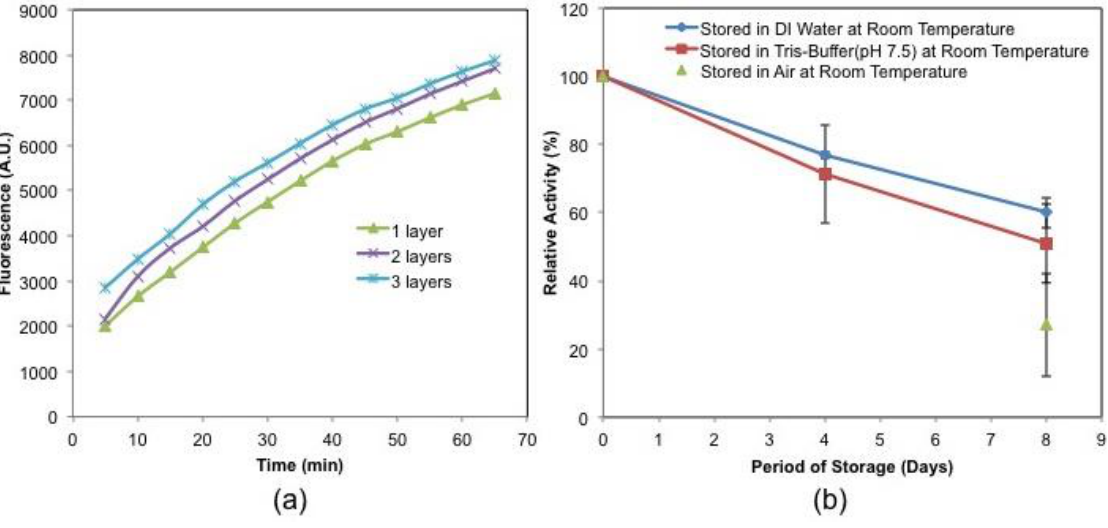
Figure 5. ( a ) Activity of the immobilized GLOD layers using Amplex ® Red reagent based assay. Fluorescence was measured for every 5 min using a fluorescence microplate reader using excitation at 530 ± 12.5 nm and the fluorescence detection at 590 ± 17.5 nm. Activity of one layer ( polyethyleneimine (PEI)/GLOD), two layers ((PEI/GLOD) 2 ) and three layers ((PEI/GLOD) 3 ) of GLOD was studied. ( b ) Stability of immobilized GLOD film when stored in de-ionized (DI) water, Tris-Buffer (pH 7.5) and air at room temperature. GLOD immobilized coverslips were tested for a period of 8 days. Error bars represent standard error when n =